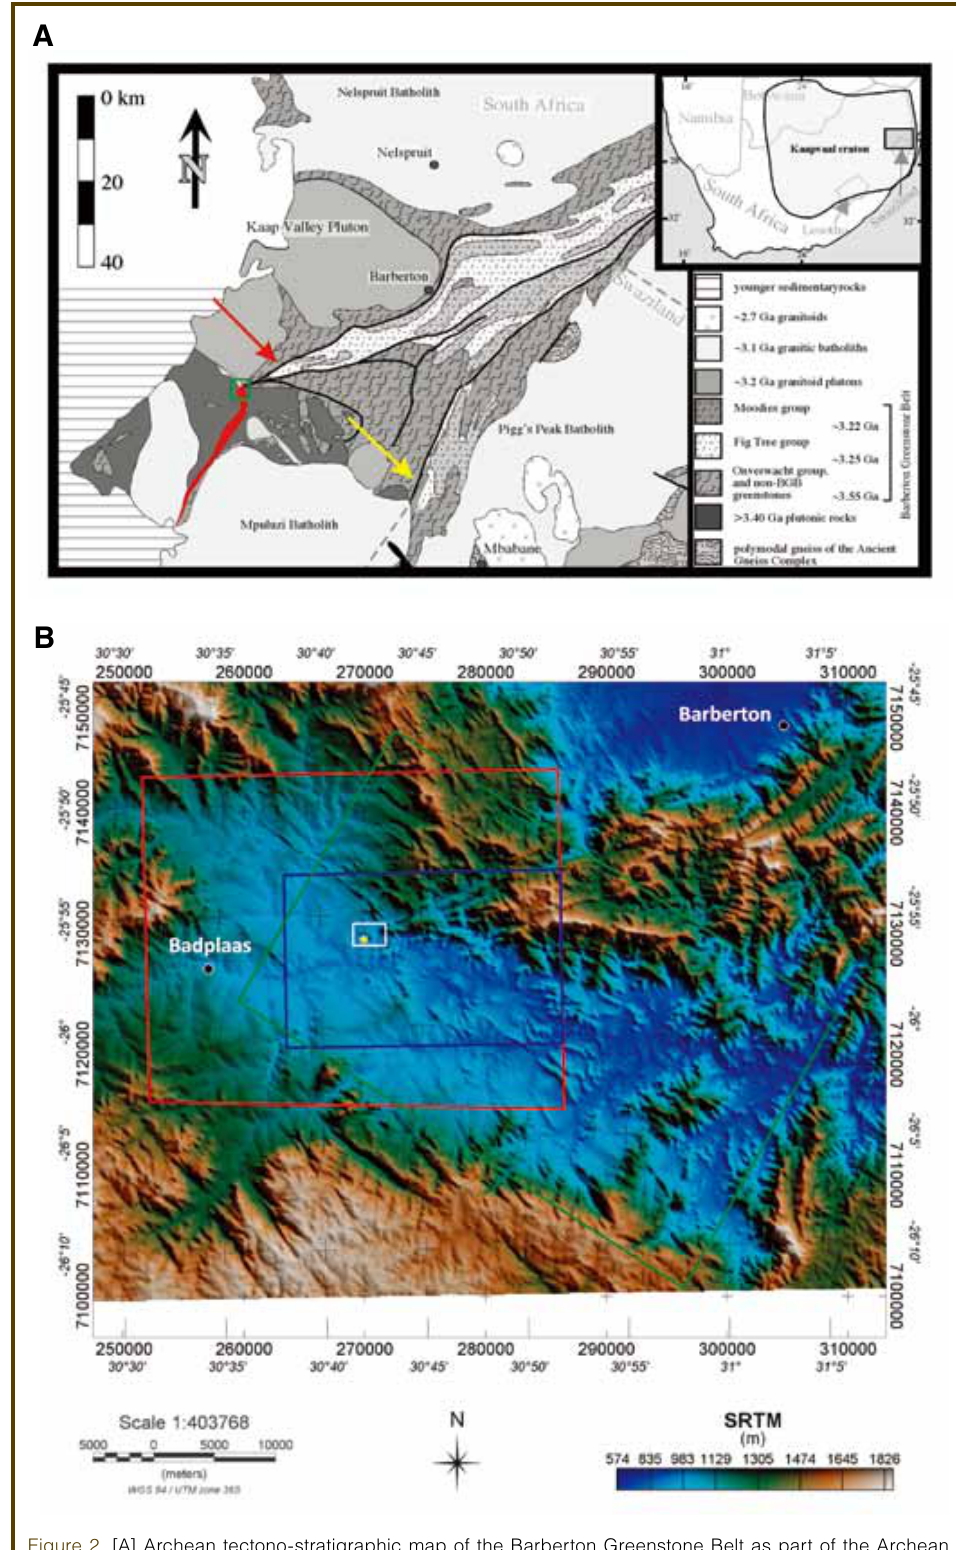
Figure 2. [A] Archean tectono-stratigraphic map of the Barberton Greenstone Belt as part of the Archean Kaapvaal craton (inset upper right). Three major tectonic terranes that comprise the Barberton region are separated by major tectonic boundaries (black solid lines), two of which (the Inyoka and Manhaar shear systems, indicated by red and yellow arrows, respectively) may represent ~3.2-Ga suture zones. Also shown in thick red is the inferred continuation of the Inyoka shear system within the granitoid terrain to the southwest of the greenstone belt, and the potential area for a deep drill site (green box). [B] SRTM image of the southern part of the greenstone belt, showing the area of ongoing high-resolution aeromagnetic surveying (dark blue box), and the potential deep drill site area (pale blue box). Also shown are the locations of Badplaas and Barberton. Note the undeformed NW-SE dykes swarm (positive topography) that cut the area that have been dated at 2990